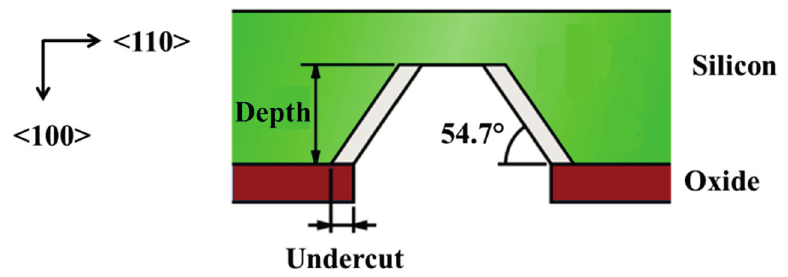
Figure 5. Sloping sidewalls are formed with anisotropic wet